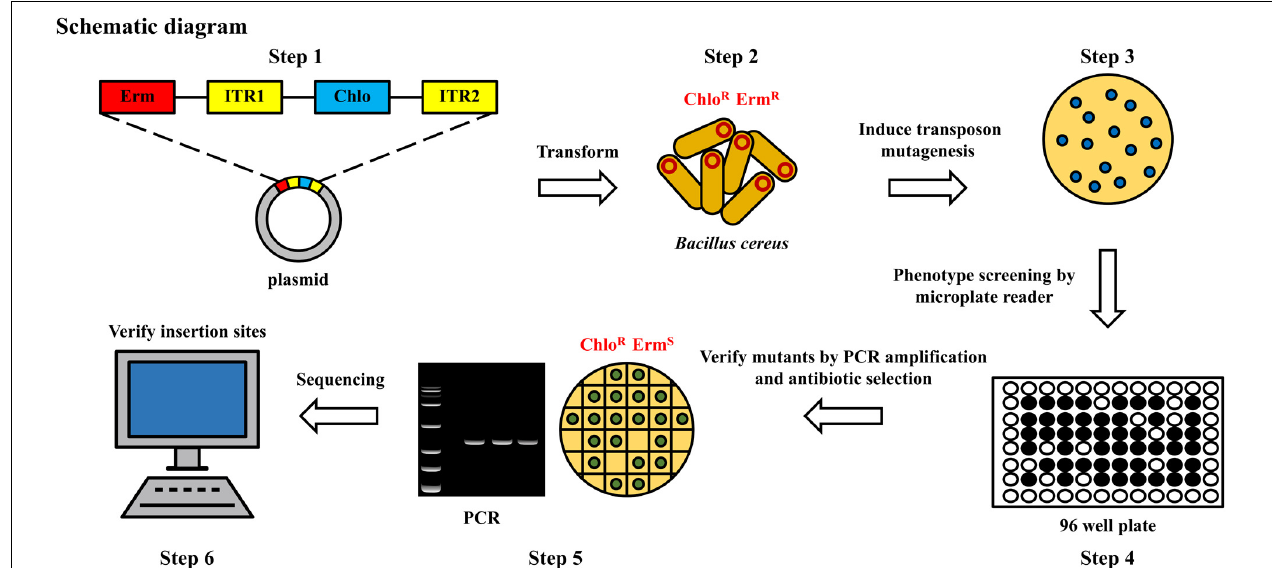
FIGURE 1 | Flow chart of construction of random mutagenesis library to screen the potential mutants with defects in biofilm formation. Erm, erythromycin; Chlo, chloromycin; R, resistant; S, sensitive; ITR1/ITR2,